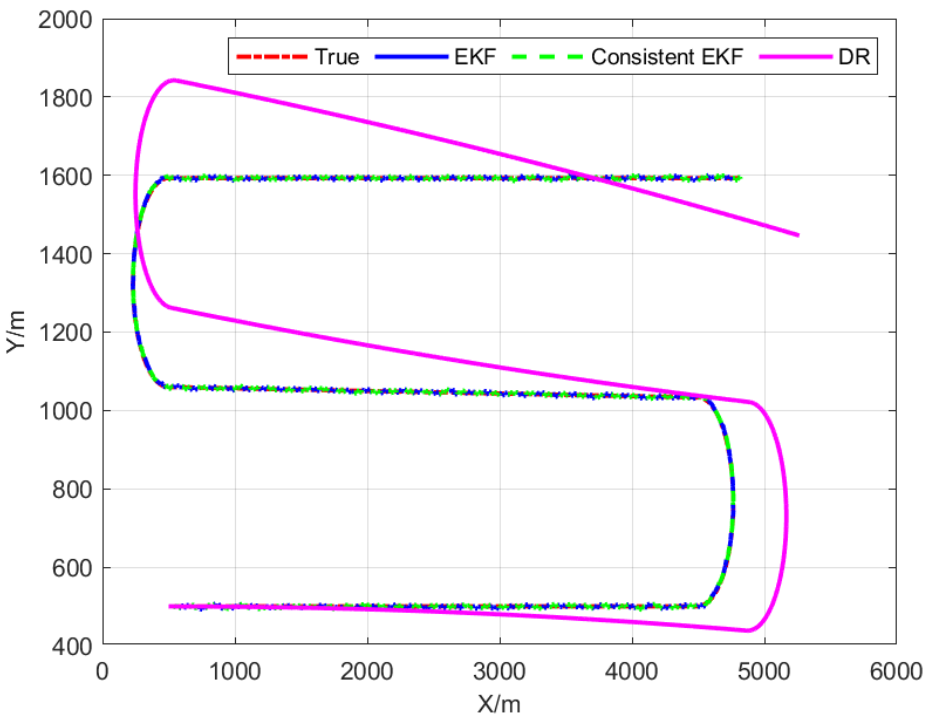
Figure 3. Real and localization trajectories of the follower